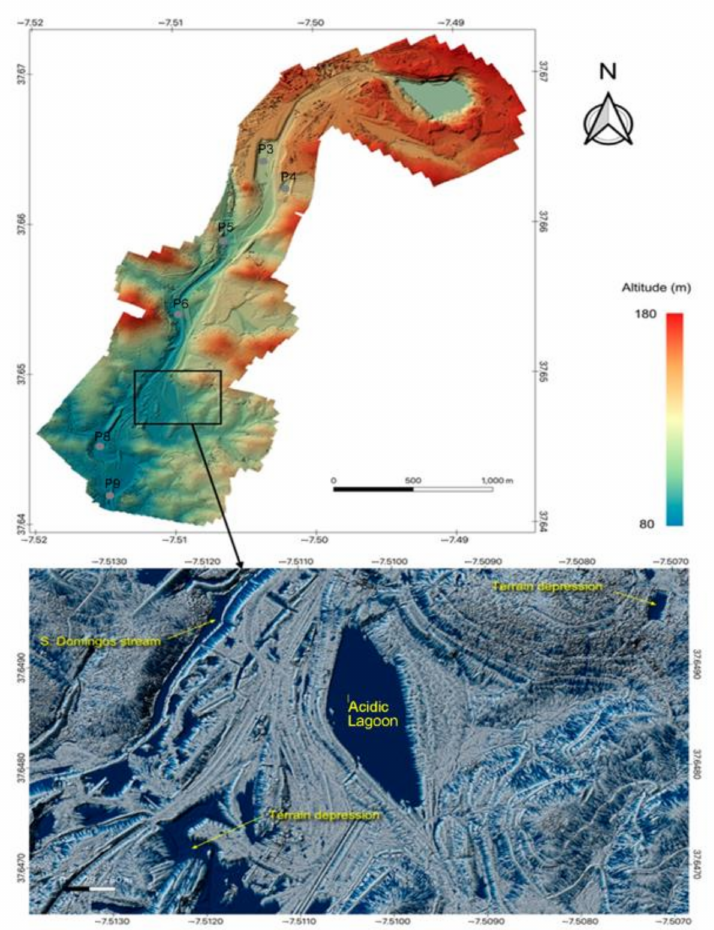
Figure 3. Digital Surface Model of the surveyed area obtained by UAV ( upper ); Section of the flow accumulation map ( lower image ) in the area with the finest sulfide wastes. In the lower part of the figure, the blue lines are flow lines of surface runoff and the blue continuous zones are areas of flow accumulation. Coordinates in WGS